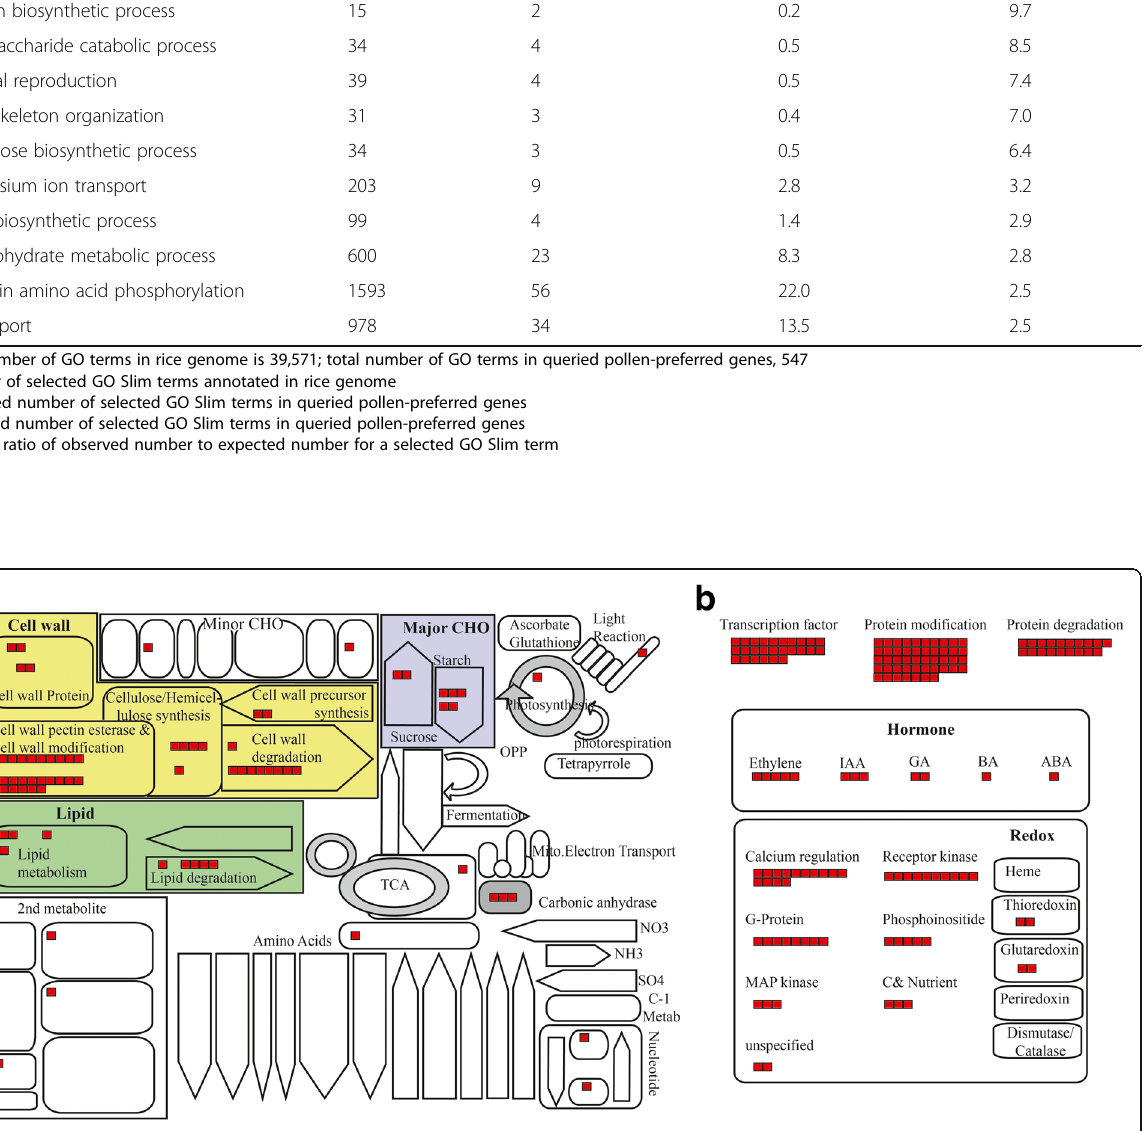
Fig. 4 MapMan analysis of late pollen-preferred genes. a Metabolic overview and ( b ) regulation overview were analyzed with 627 genes. Cell wall organization and modification, lipid metabolism, and carbohydrate metabolism were dominant MapMan terms in metabolic overview. Red boxes in these overviews indicate late pollen-preferential. Genes associated with transcription factors, protein modification, and protein degradation were identified from regulation overview. In addition, diverse hormone responses, signaling pathway components, and redox responses for late pollen development were visualized. Detailed information about overviews is shown in Table